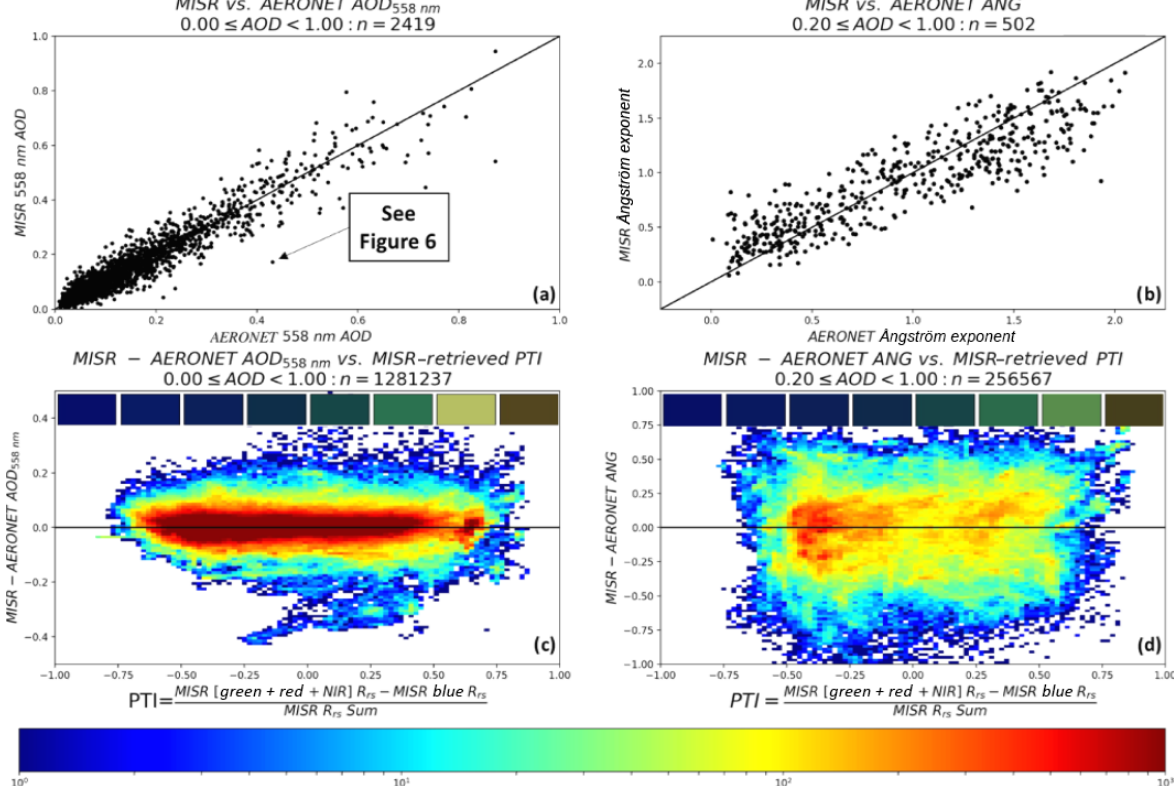
Figure 7. MISR vs. AERONET AOD and ANG statistical comparisons for all cloud-screened coincidences. (a) MISR vs. AERONET green-band (558nm, interpolated for AERONET) AOD data; (b) MISR vs. AERONET ANG data, conditioned on AERONET 558nm AOD > 0.20. (c) Two-dimensional histogram of all MISR–AERONET AOD differences vs. MISR-retrieved PTI (Eq. 8). For this panel (and d ), we compare all cloud-free MISR data to AERONET, meaning there can be over 1000 MISR–AERONET data points for each unique AERONET observation. (d) Two-dimensional histogram of all MISR–AERONET ANG differences vs. MISR-retrieved PTI (Eq. 8). For panels (c) and (d) , the eight colored rectangular boxes represent the averaged MISR-RA-retrieved R rs values (brightness enhanced by 10x and made into RGB images) over the x -axis range that they physically intersect in the